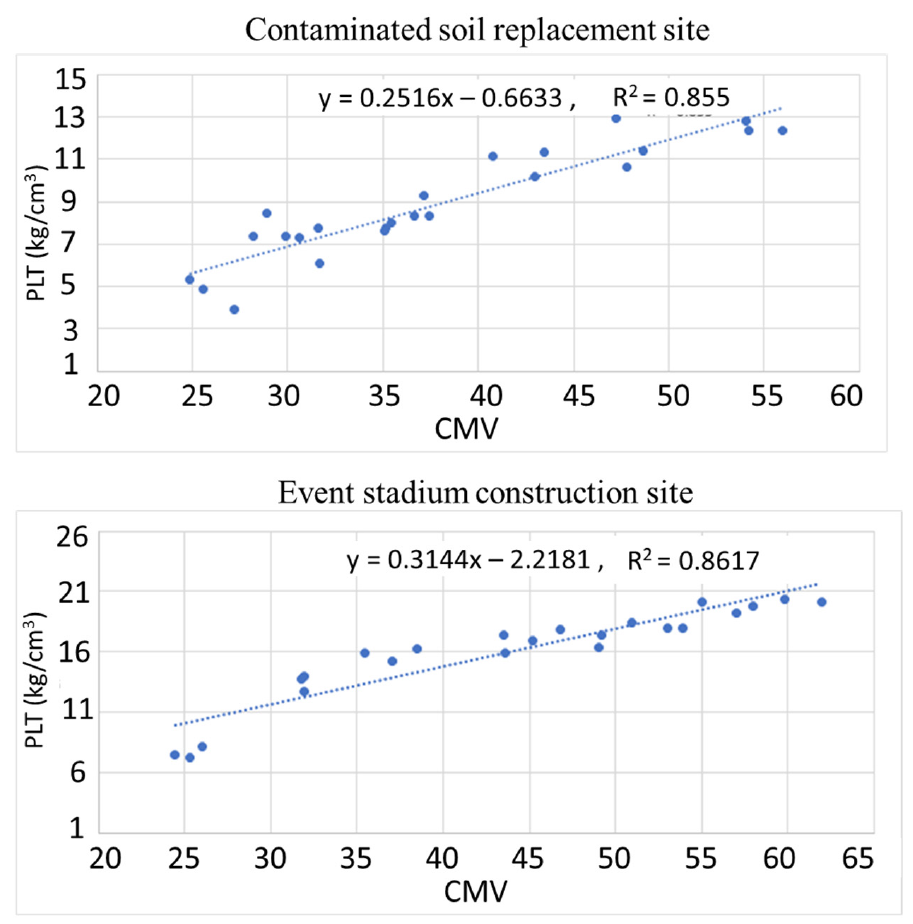
Figure 9. Regression analysis for the correlation between the CMV and bearing coefficients.